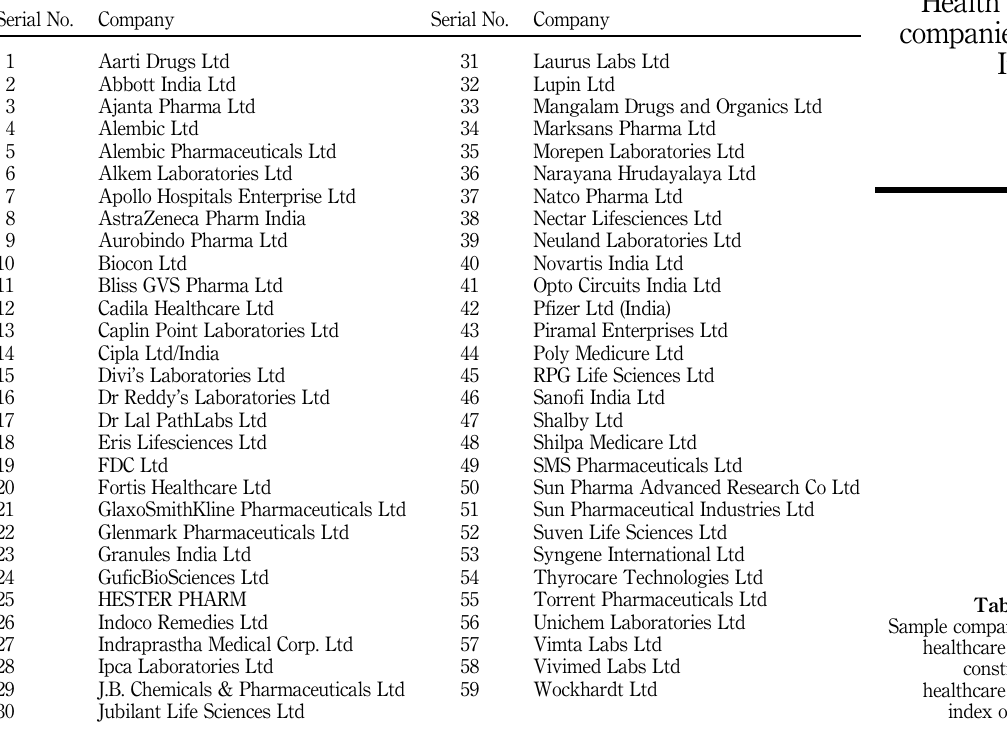
Table III. Sample companies